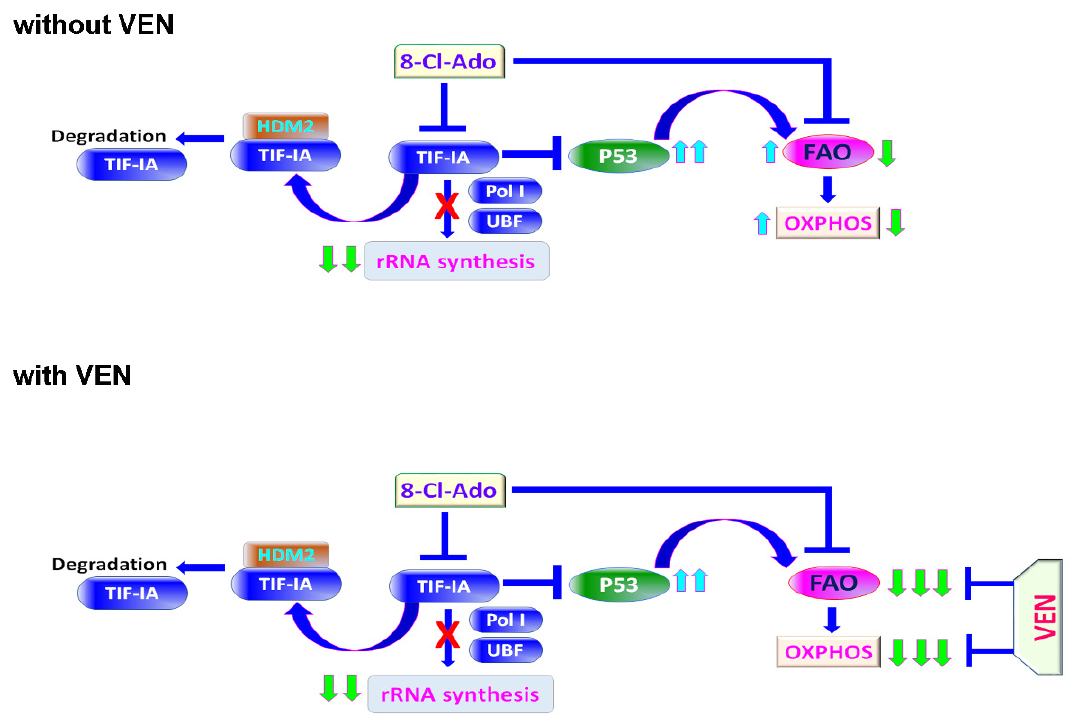
Figure 7. Schematic diagram of a proposed mechanism of synergy of combining 8-Cl-Ado with VEN for targeting of metabolic vulnerabilities in LSC-enriched blasts. Top, in the absence of VEN. Bottom, in the presence of VEN. TIF-IA, transcription initiation factor IA; Pol I, RNA polymerase I; UBF, upstream binding factor; HDM2, human homolog of mouse double minute 2; FAO, fatty acid oxidation; OXPHOS, oxidative phosphorylation; VEN, venetoclax; 8-Cl-Ado, 8-chloro-adenosine. VEN combination treatments with either an HMA drug or low-dose cytarabine demon- strate superior clinical outcomes compared to single-agent treatment in AML